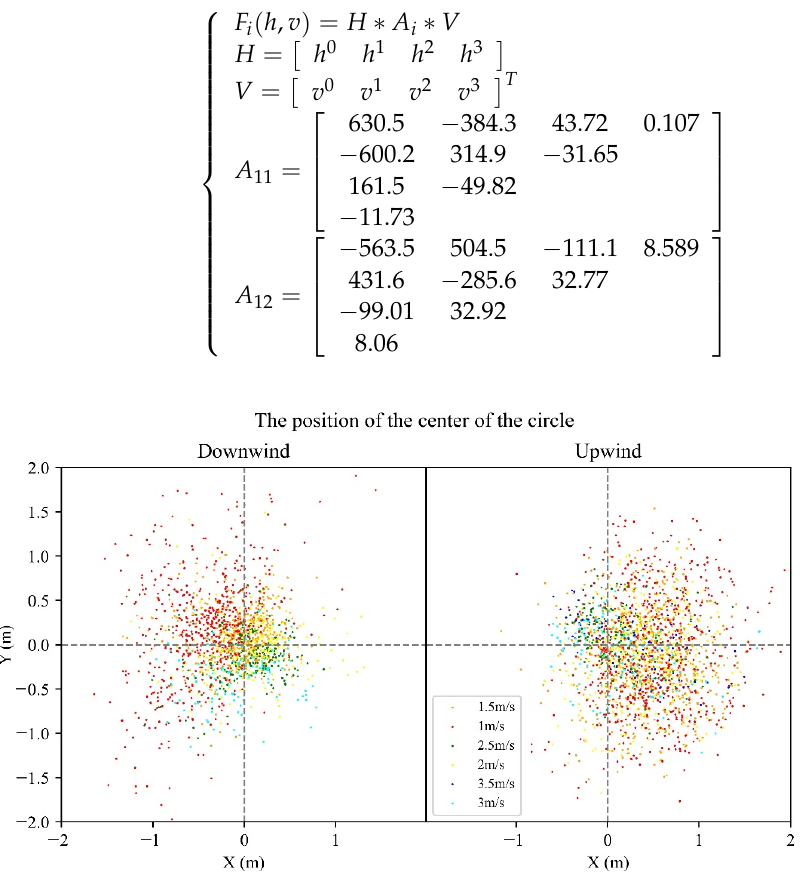
Figure 10. Relative positions of the inscribed circle and the circumscribed circle. Note: The flight direction of the drone is parallel to the x-axis, and it flies in the negative direction of the x-axis; the center of the inscribed circle in the coordinate system is the origin, and the data points in the coordinate system are the position of the center of the circumscribed circle relative to the center of the inscribed circle.